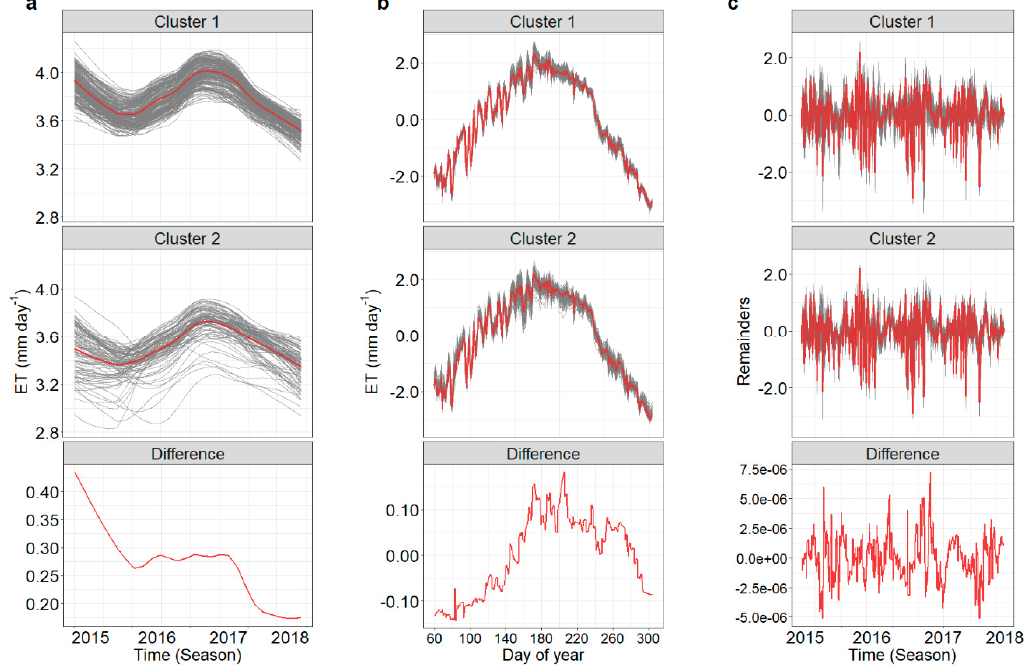
Figure 6. Plots of time-series clusters and differences of centroids for each of the components: ( a ) trend; ( b ) seasonality; and ( c ) remainder. Red line defines the centroid of each cluster, while grey lines are the time series of the different pixels within each cluster.